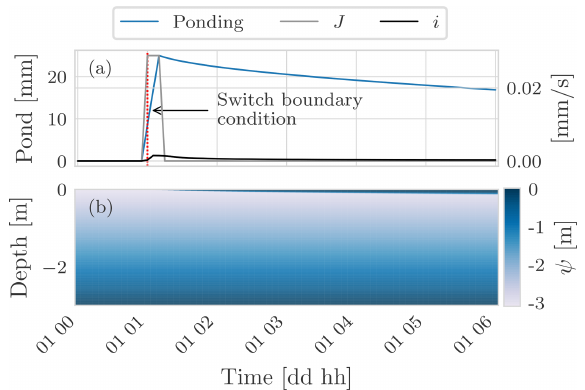
Figure C6. (a) A comparison between the rainfall intensity J and actual soil infiltration i . The rainfall intensity exceeds the actual in- filtration rate so water builds up at the soil surface (blue line). (b) The time evolution of the water suction within the soil. From the nu- merical point of view, as water builds up at the soil surface it would be necessary to switch the boundary condition from Neumann type to Dirichlet type.